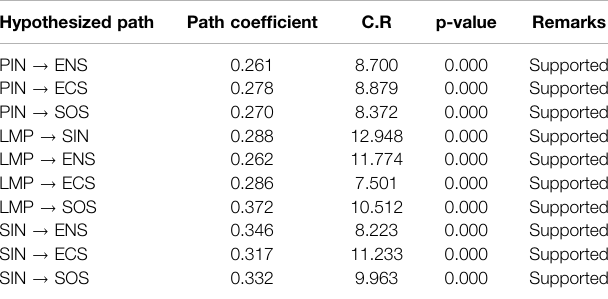
TABLE 8 | Results of path coef fi cients (direct effects).